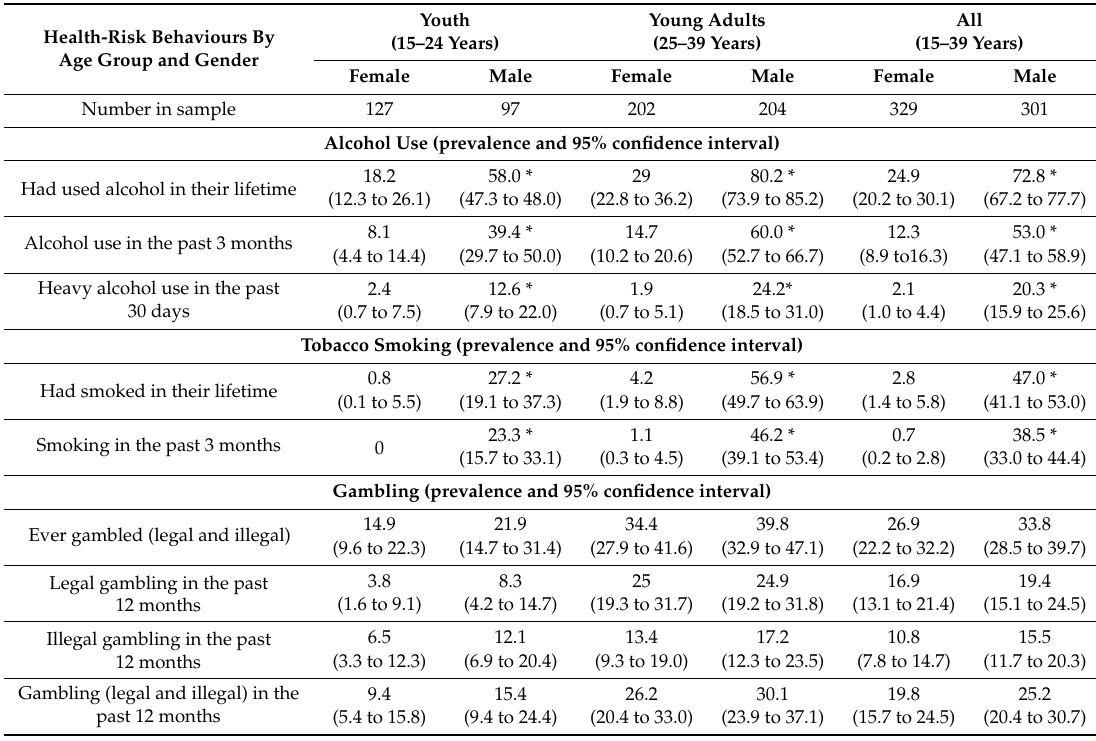
Table 2. Prevalence and 95% confidence interval of health-risk behaviours by age group and gender in Chiang